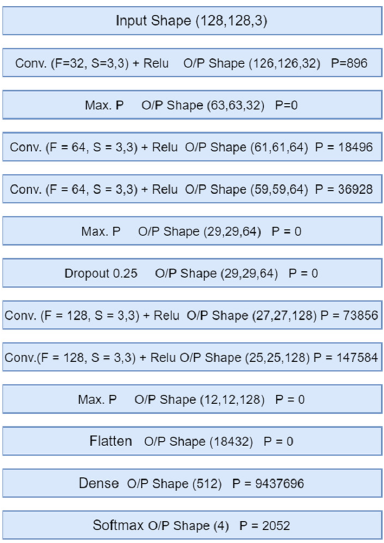
Figure 3. ↑ , ↓ , BS, FC, BN, and O/P indicate upsampling, downsampling batch size, fully connected layer, batch normalization, and output, respectively. ( a ) The architecture of Generative adversarial networks used in this study. ( b ) Variational autoencoder architecture.